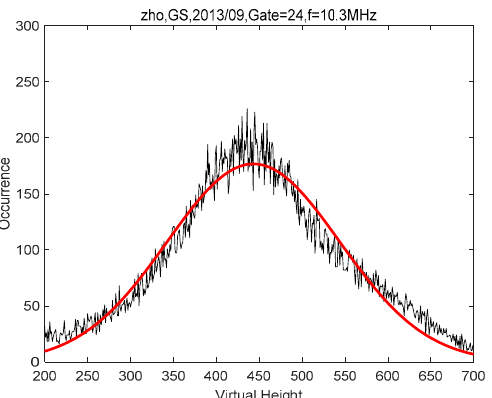
Figure 3. The virtual height distribution of ground backscatter echoes for range gate 24 (1215–1260 km) at the Zhongshan radar in September 2013. The black line represents the actual virtual height calculated by the elevation angle and group range, and the red line represents the result of fitting with a Gaussian function.